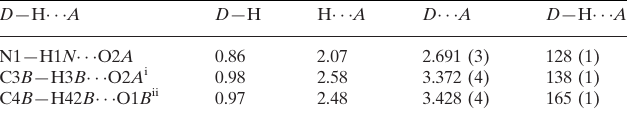
Hydrogen-bond geometry (A˚ , (cid:3)